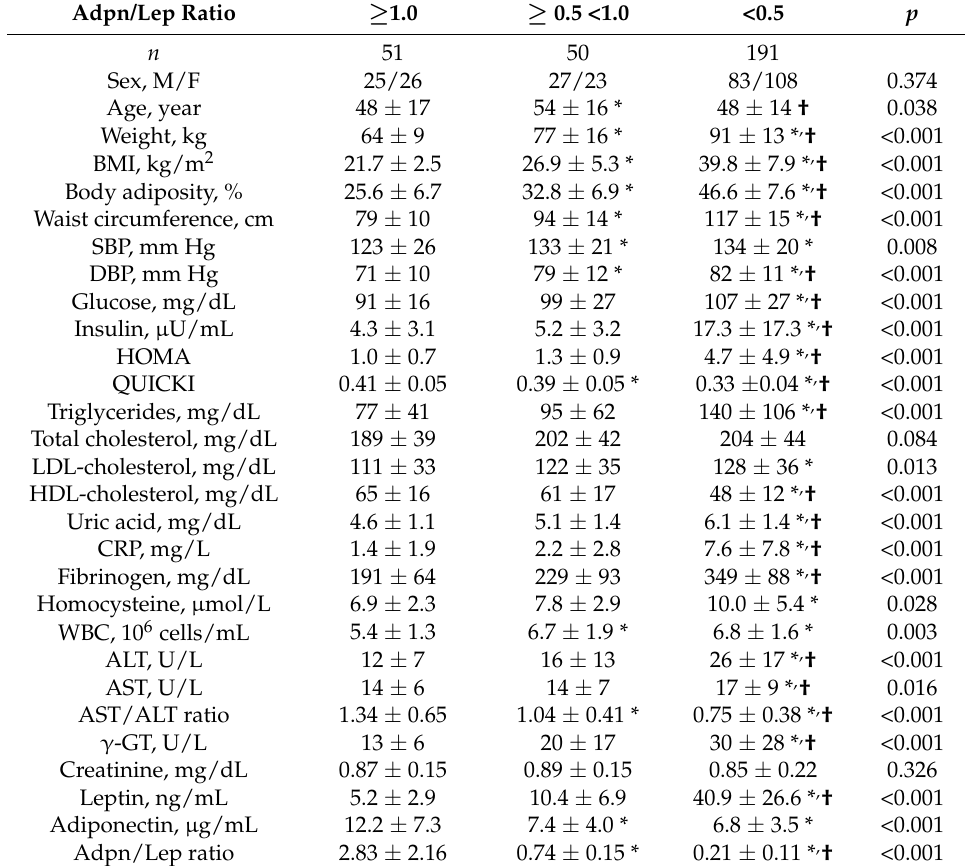
Table 1. Demographic and biochemical characteristics of the individuals classified according to the Adpn/Lep